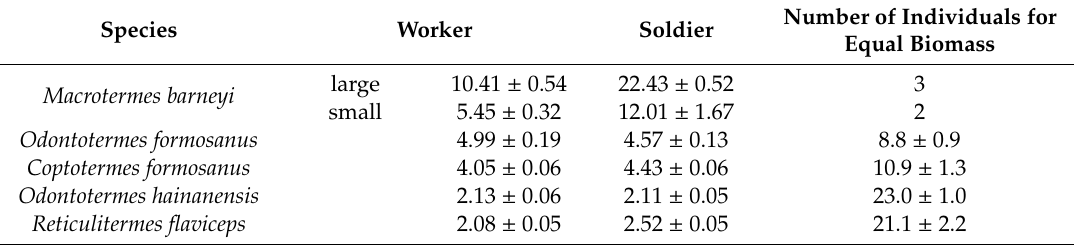
Table 1. The weights (mean ± standard error) of the di ff erent castes for each termite species. Note M. barneyi has two castes of workers (large and small). Only workers were used in the laboratory experiments; soldier weights are provided for comparison only. Numbers of individuals for equal biomass (mean ± standard error) were based on the average weight of 5 M. barneyi workers (3 large + 2 small) of 42.1